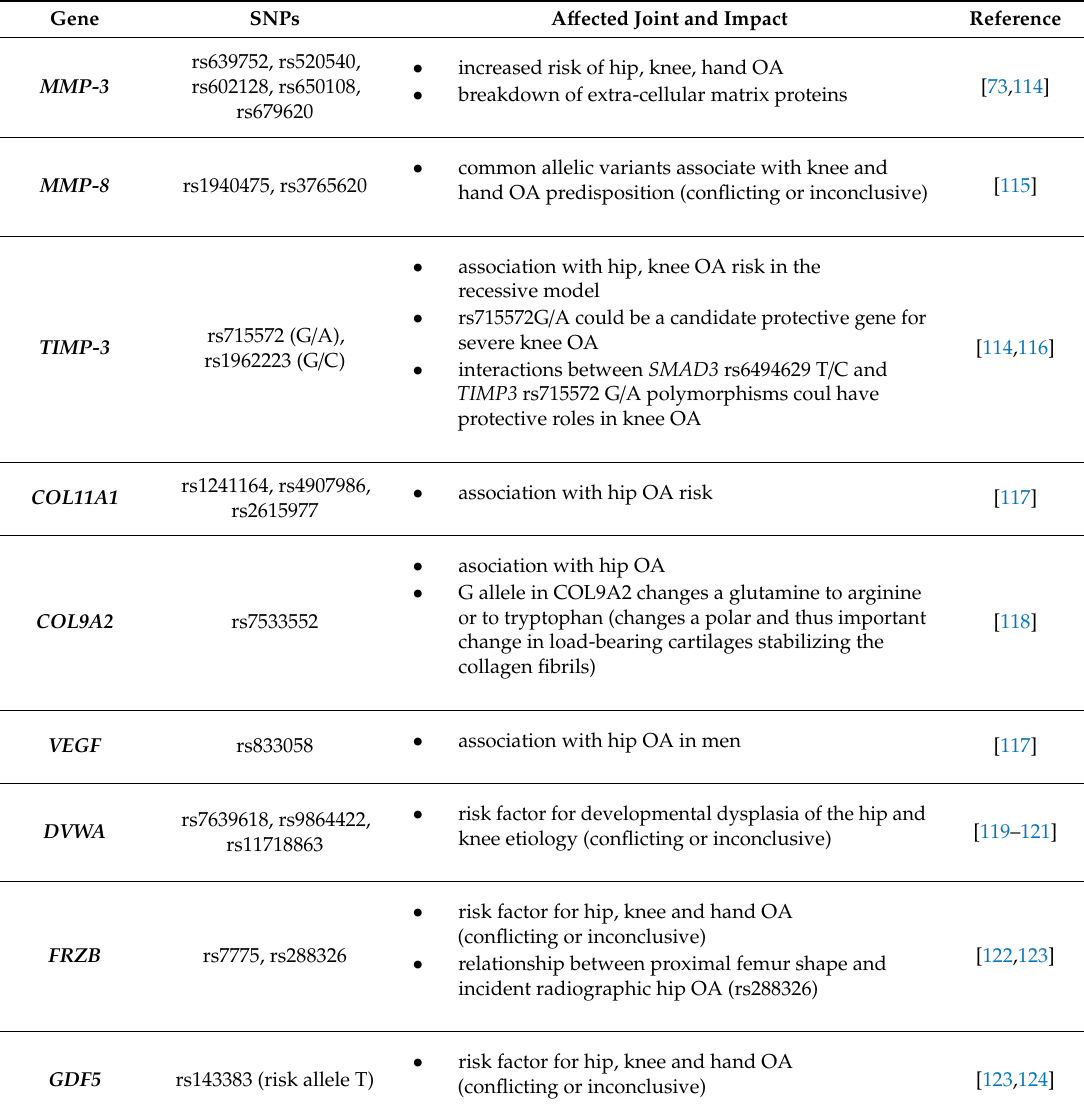
Table 2. Polymorphism from selected genes correlated with the risk of